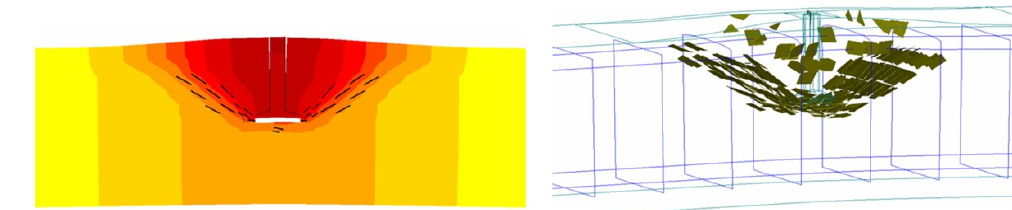
Figure 16. Deformation of the anchorage area and the formation of cracks with a width greater than 0.5 mm—anchor without supplementary reinforcement.